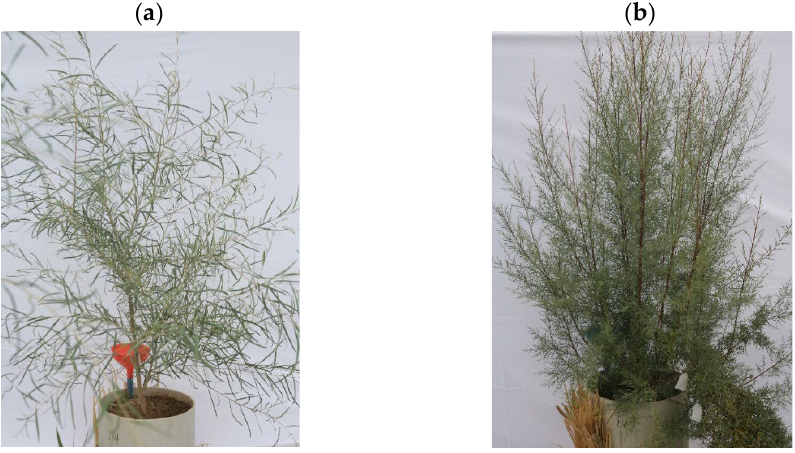
Figure 1. Populus euphratica ( a ) and Tamarix ramosissima ( b ) growing in lysimeters.